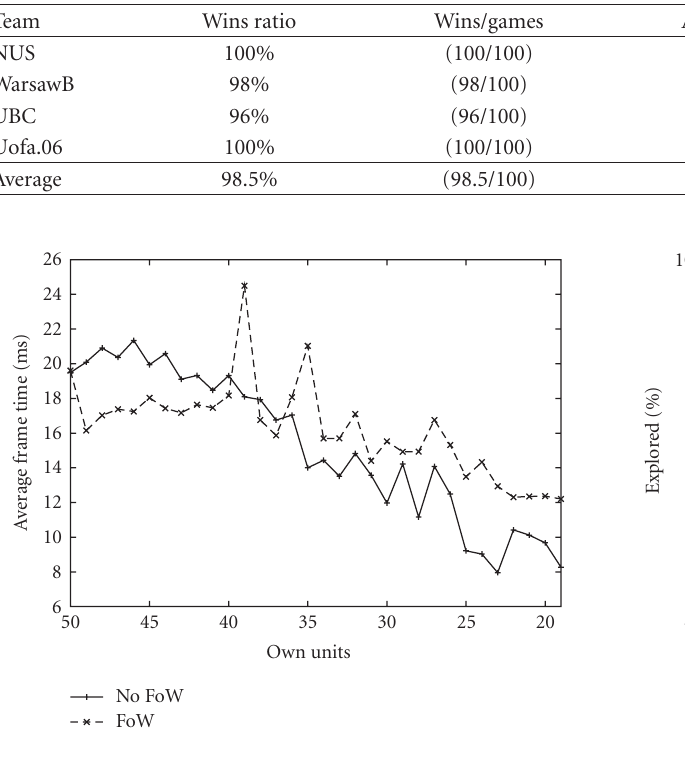
Table 8: Experiment results when FoW is enabled for our bot.